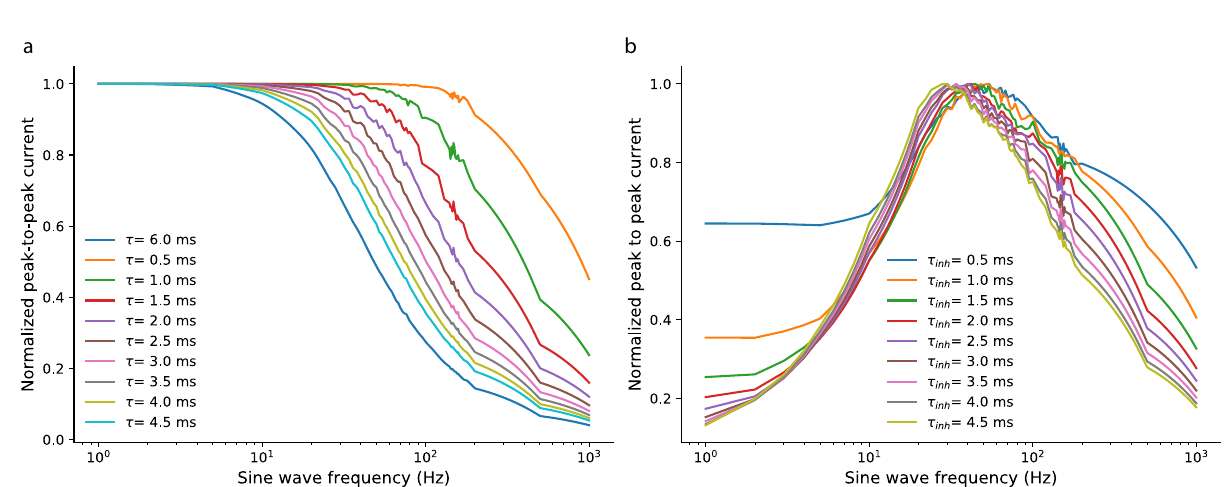
Fig. 6 DPI low- and band-pass fi lter characteristics for spiking inputs. a Behavioral simulation results for the normalized steady-state response of the Differential Pair Integrator (DPI) to spike trains encoding an input sine wave, as a function of sine wave frequency. The DPI is able to reproduce a standard low-pass fi lter behavior for spiking inputs. b Band-pass fi lters resulting from the combination of DPIs with different time constants. A fi rst-order band-pass fi lter results from subtracting the time responses to sine waves of varying frequencies of a single excitatory DPI synapse with a given time constant with the time responses of an inhibitory DPI synapse with a different time constant. The band-pass fi lters depicted here were obtained by using an excitatory DPI with a time constant of 6 ms and subtracting the activity of inhibitory DPIs with time constants ranging from 0.5 – 4.5